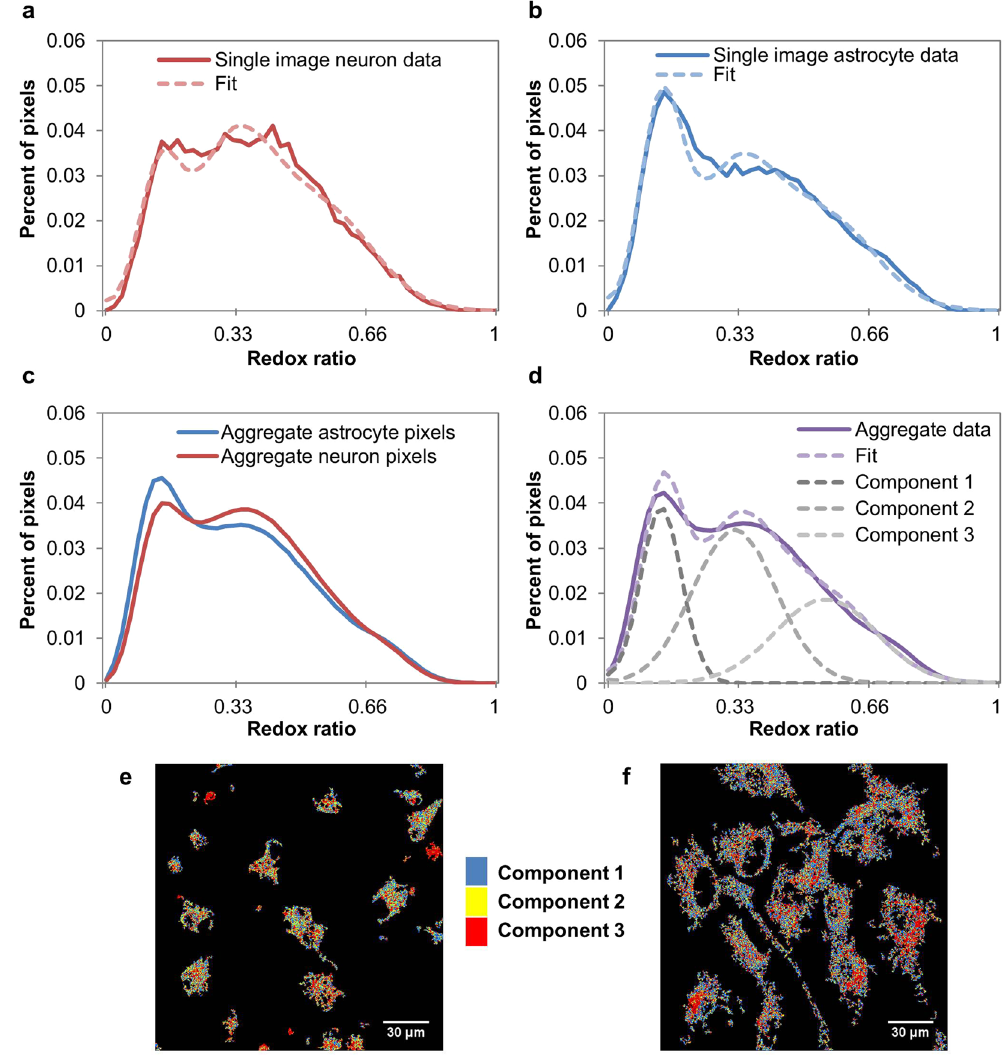
Figure 3. Redox ratio distributions are well-described by the sum of three underlying Gaussian components. ( a,b ) Representative redox ratio distributions for individual neuron ( a ) and astrocyte ( b ) images illustrate how distributions are multimodal and astrocytes have a higher peak at the first mode than neurons. ( c ) Distributions aggregated over all masked images for each cell type further confirm these trends. ( d ) Data from both cell types is combined to determine three underlying Gaussian components. ( e,f ) Images of neurons ( e ) and astrocytes ( f ) are false-colored to show pixels corresponding to each